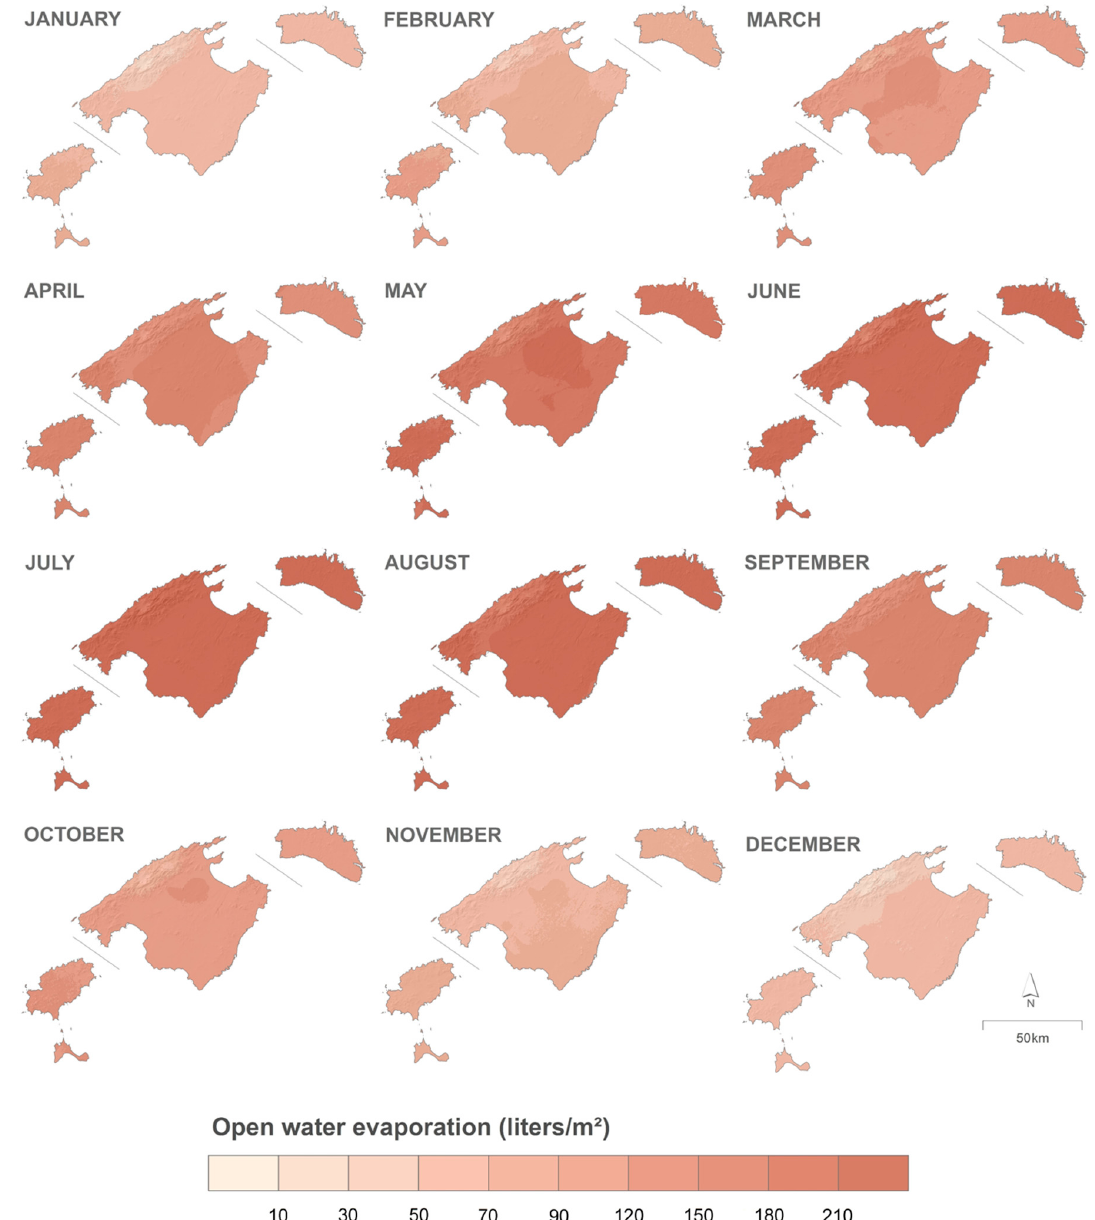
Figure 4. Spatial distribution of the interpolated monthly open water evaporation in the Balearic Islands (2006–2015 average).